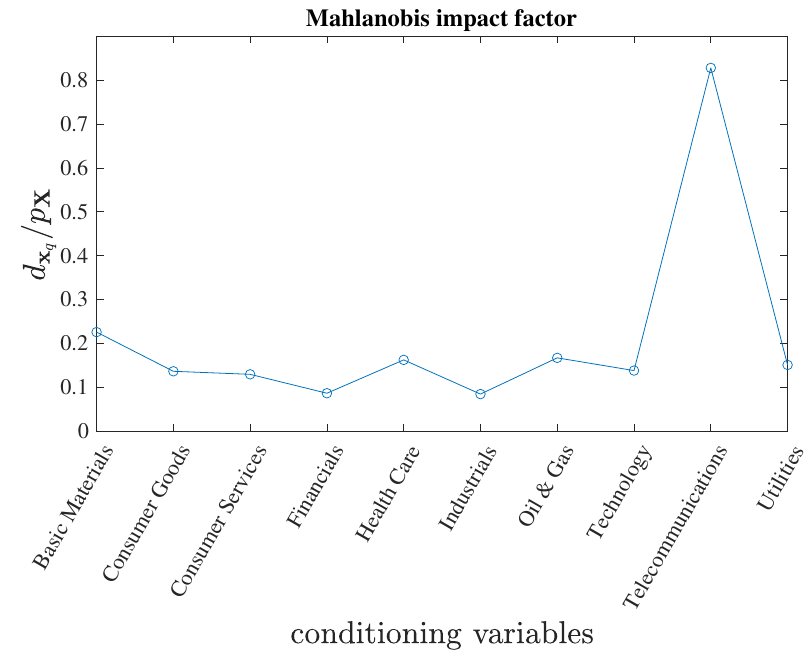
Figure A2. Value of B x = d x ∗